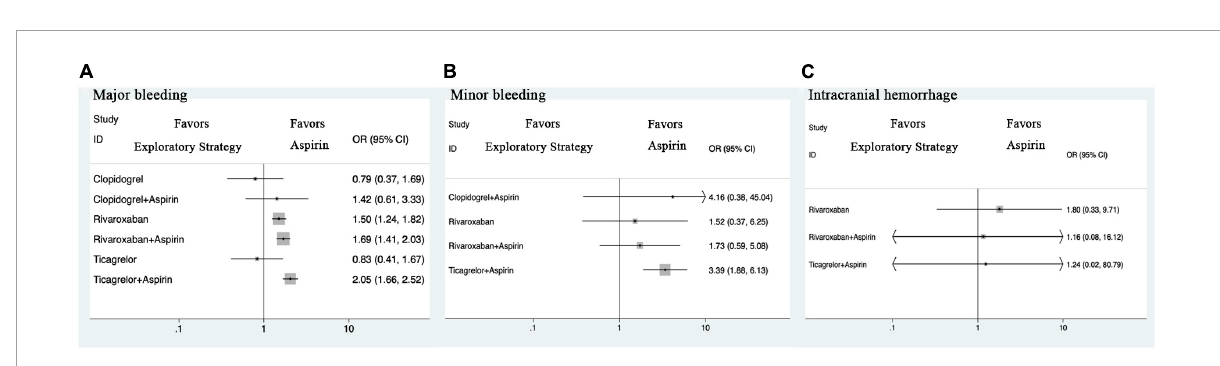
FIGURE3 Forest plots for safety outcomes. (A) Major bleeding. (B) Minor bleeding. (C) Intracranial hemorrhage. CI, credible intervals; OR, odds